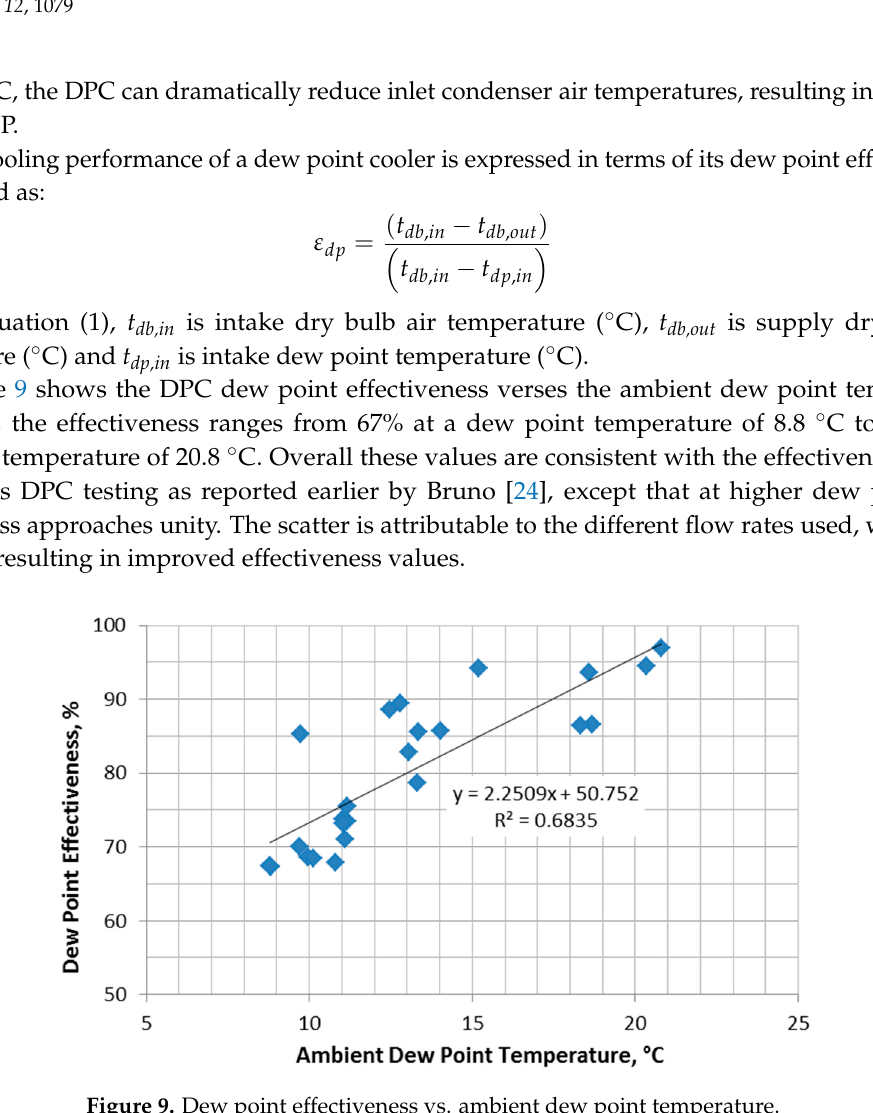
Figure 9. Dew point effectiveness vs. ambient dew point temperature.